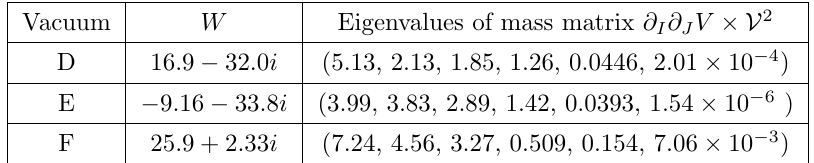
Table 4 . Explicit values of (cid:13)ux superpotential and mass eigenvalues in M Pl = 1 unit. Note that we have diagonalized the mass matrix and the eigenvalues are displayed in the descending order.